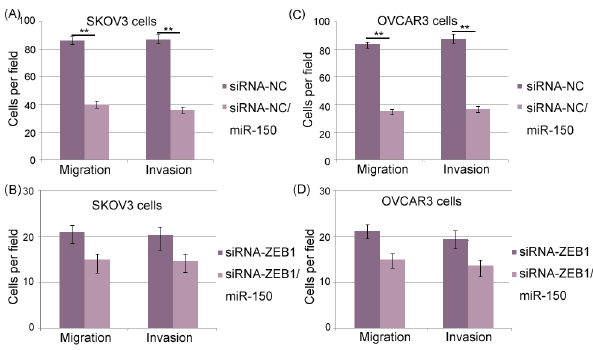
Figure 6. MicroRNA-150 (miR-150) inhibits epithelial ovarian cancer (EOC) cells migration and invasion in vitro by targeting Zinc Finger E-Box Binding Homeobox 1 (ZEB1). (A and C) Transwell migration assay and Matrigel invasion assay of EOC cells transfected with siRNA-NC, and EOC cells transfected with siRNA-NC and miR-150 vector. (B and D) Transwell migration assay and Matrigel invasion assay of EOC cells transfected with siRNA-ZEB1, and EOC cells transfected with siRNA-ZEB1 and miR-150 vector.